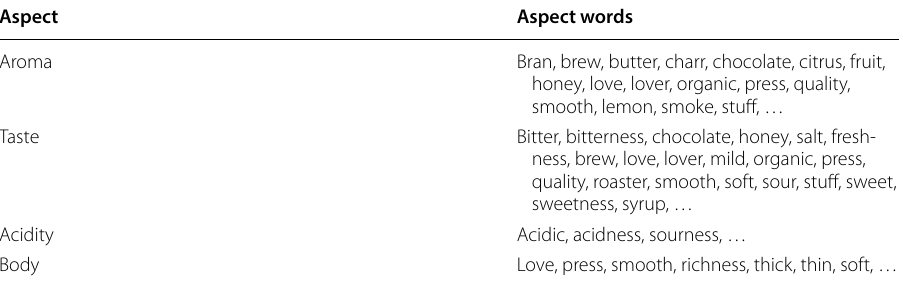
Table 10 Aspect word set of Coffee